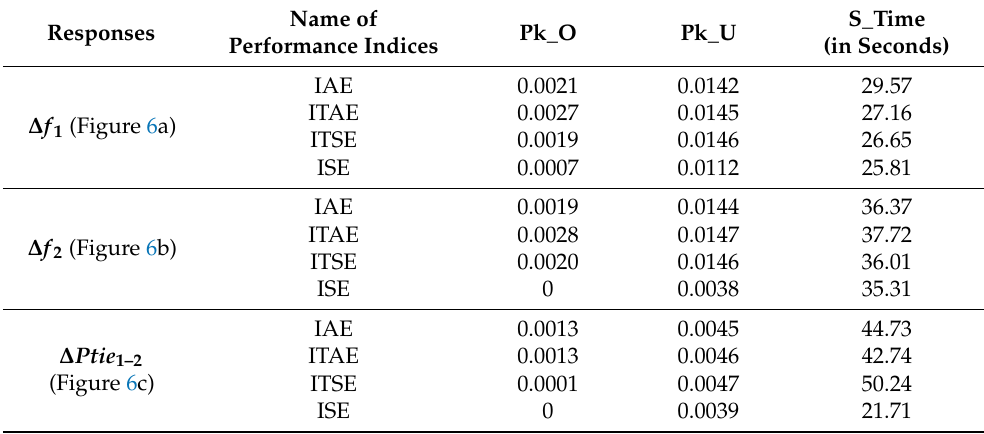
Table 3. Peak anomaly and duration of settling for outcomes in Figure 6a–c in the case of scheme-1 employing SHO-optimized PDN(FOID) controller for diverse performance indices.